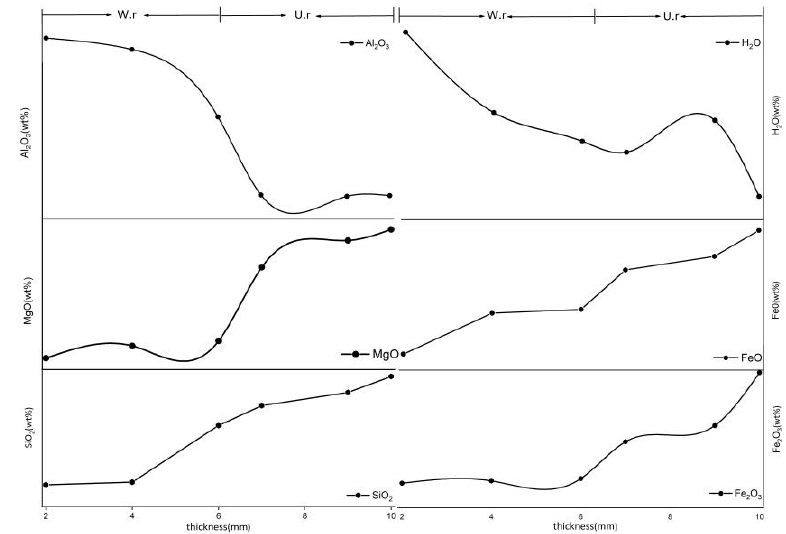
Figure 6. Changes in chemical composition of weathering rinds and unweathered cores with different thicknesses.